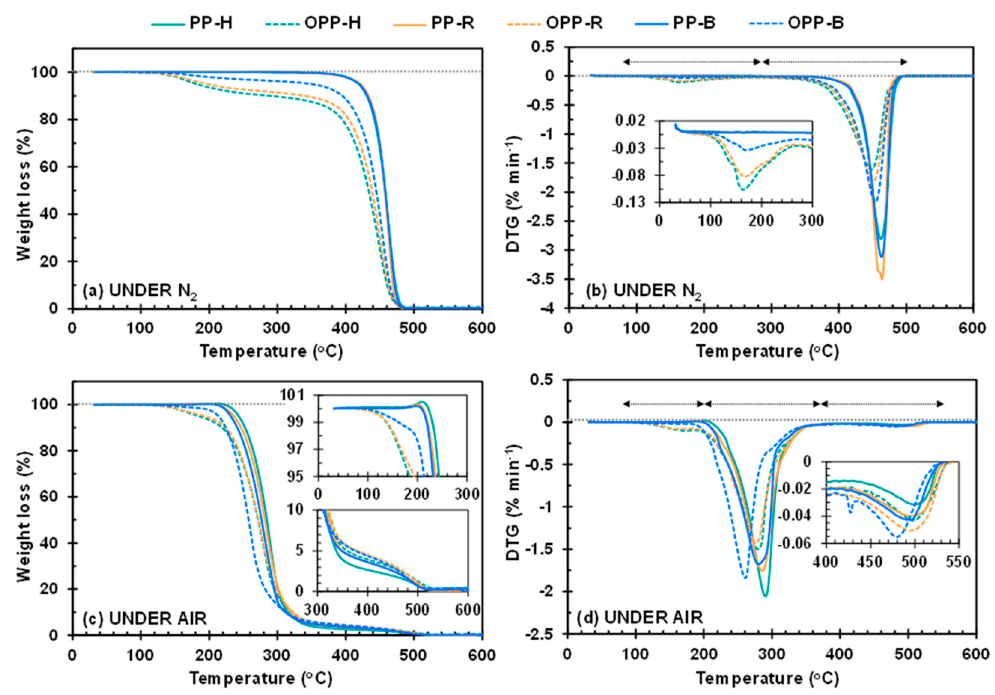
Figure 3. TGA and DTG curves for PP granules before (solid lines) and after oxidation (dashed lines) at a heating rate of 10 °C/min: ( a ) TGA and ( b ) DTG curves in nitrogen, ( c ) TGA and ( d ) DTG curves in air. The double arrows in ( b ) and ( d ) indicate the temperature ranges for the weight loss steps of the thermal decomposition of oxidized samples.